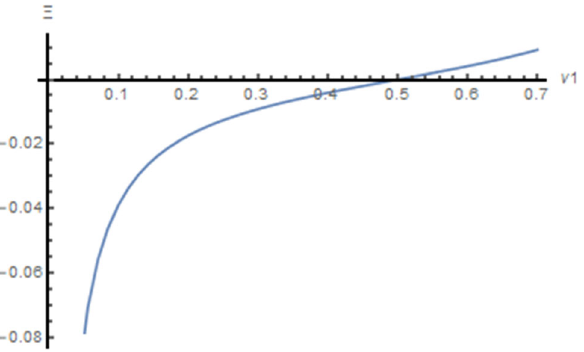
Fig. 9 In this diagram the solid line expresses the amount of Ξ(ν 1 ) in Eq. (22) based on parameter ν 1 . It will be realized if ν 1 ≈ 0 . 49 then Ξ(ν ) tends to zero and for greater quantities than ν 1 the positive area